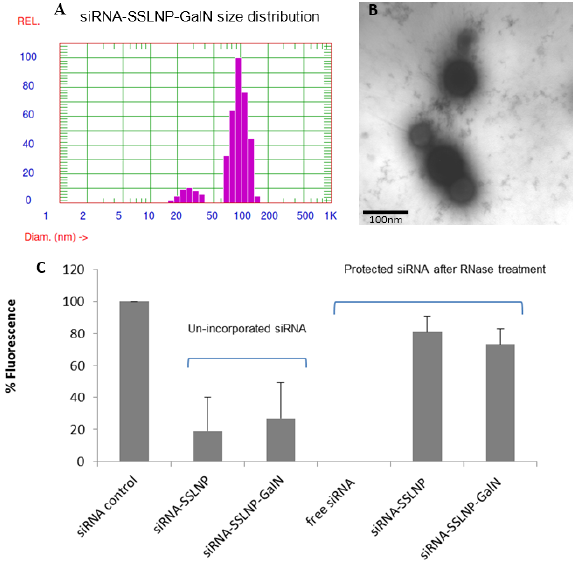
Figure 3. Physicochemical characterization of siRNA-SSLNP-GalN: ( A ) Particle size distribution showing SSLNP-GalN peak at 91 ± 13 nm; ( B ) Transmission electron microscopy (TEM) image of siRNA-SSLNP-GalN, scale bar = 100 nm; ( C ) Results of SYBR Green-II exclusion assay. Bars represent percentage of siRNA before (un-incorporated) and after treatment with RNase enzyme (mean ± SD; n = 3 replicates/group).